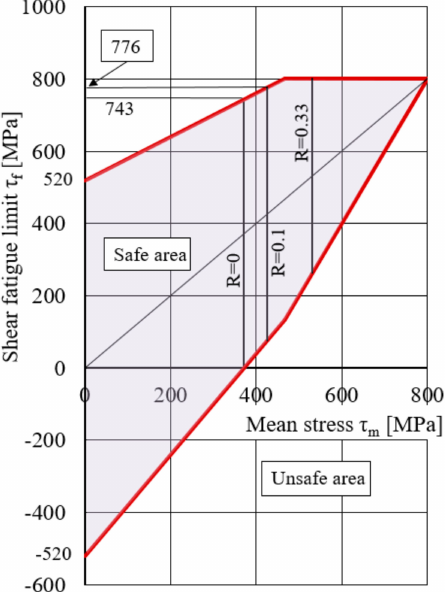
Figure 3. Smith diagram for torsion dynamic loading of the actual material. The used fatigue ratios R = 0, R = 0.1 and R = 0.33 are